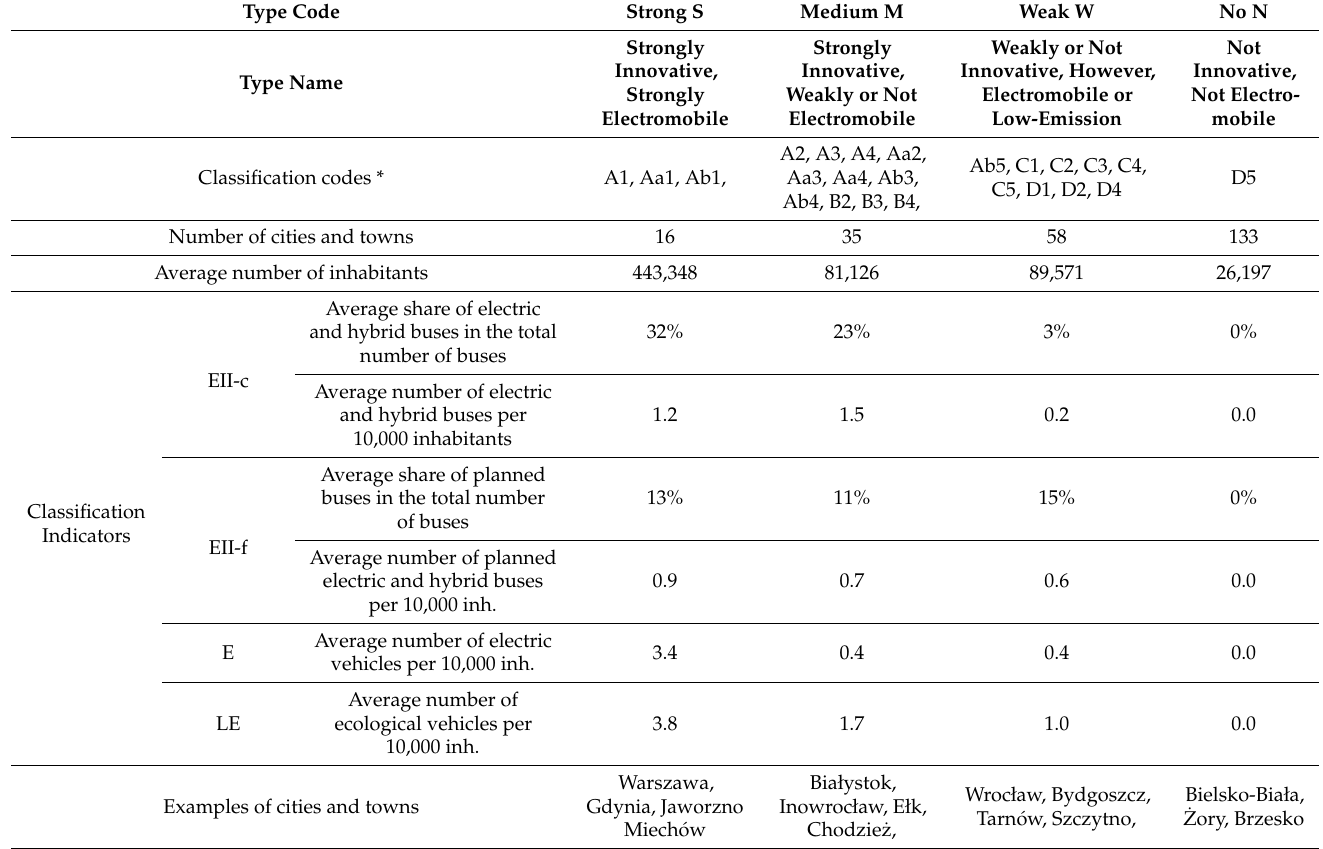
Table 8. Typology of cities in terms of electromobility and